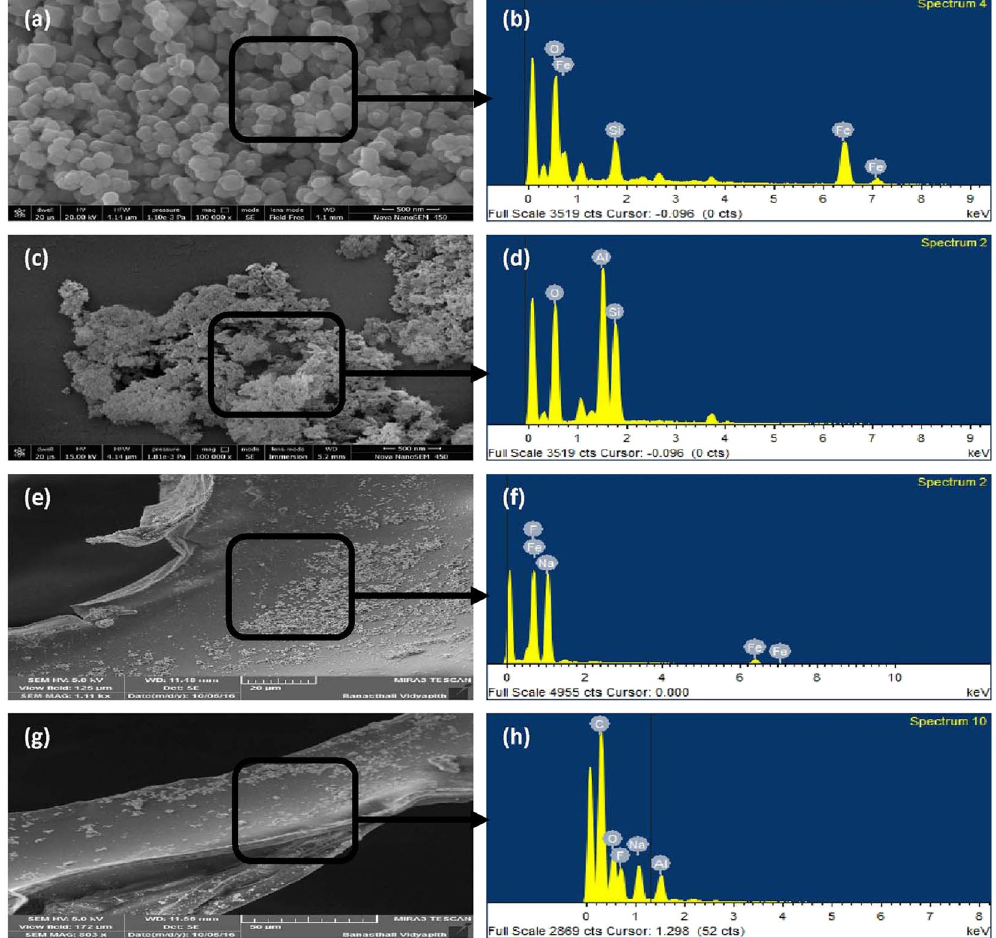
Figure 1. ( a ) and ( b ) show the FESEM image and EDX spectrum of Fe NPs, ( c ) and ( d ) show the FESEM image and EDX spectrum of Al NPs, ( e ) and ( f ) shows FESEM image and EDX spectrum of Fe NPs-PUF after F adsorption, and ( g ) and ( h ) show the FESEM image and EDX spectrum of Al NPs-PUF after F